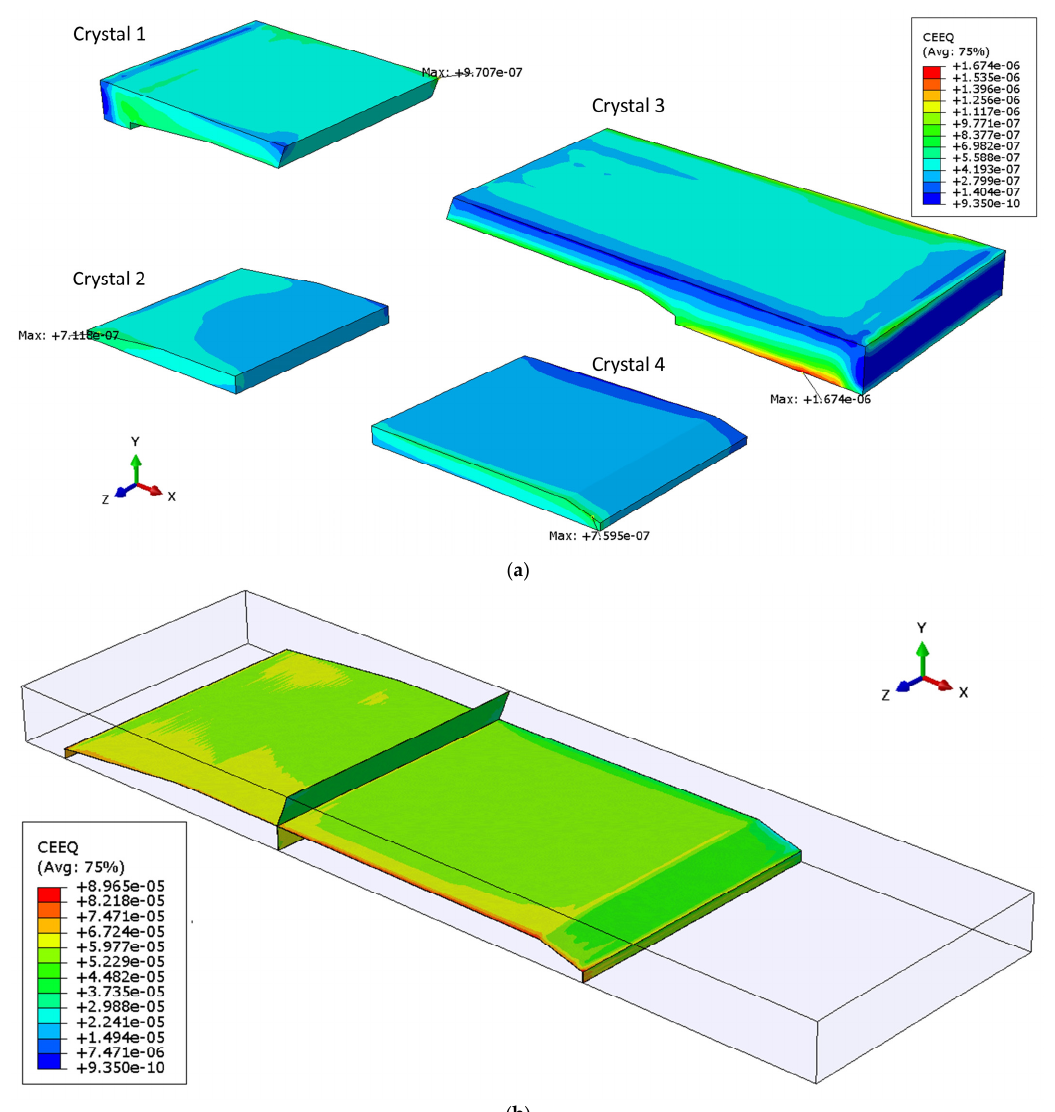
Figure 9. Equivalent creep strain contour of Sample 1 in: ( a ) each crystal, ( b ) grain boundary region.